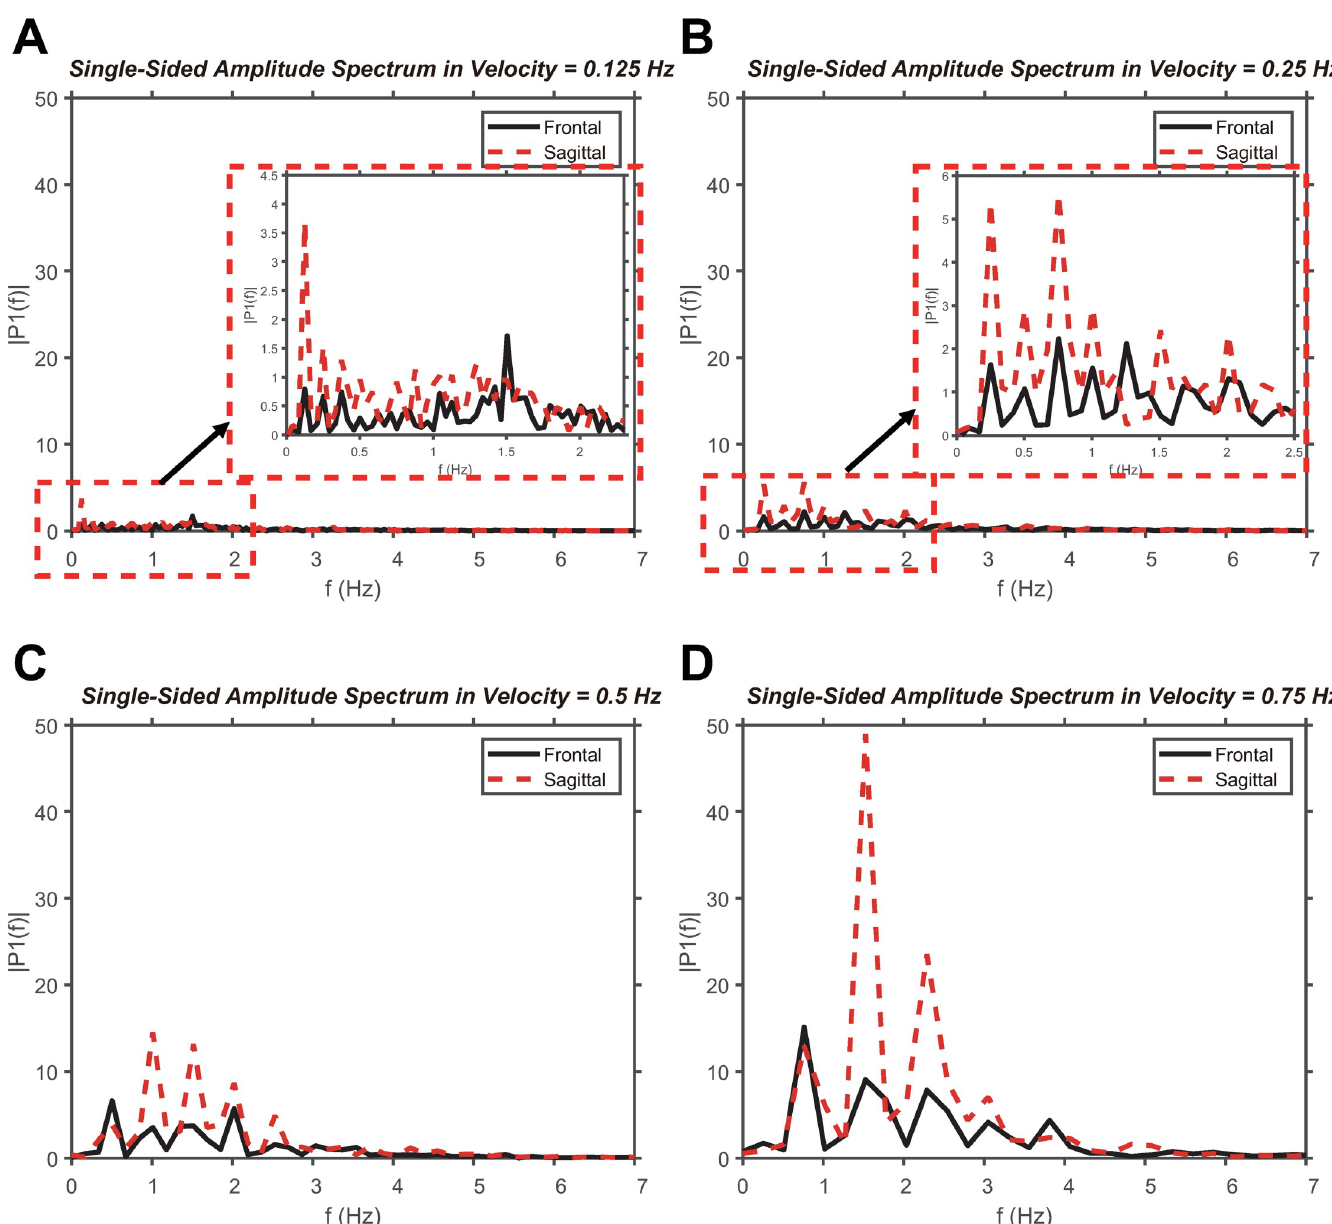
Fig 10. Frequency analysis of ω . Analysis of the ω values of the frontal and sagittal planes within the frequency domain at (A) V1 , (B) V2 , (C) V3 , and (D) V4